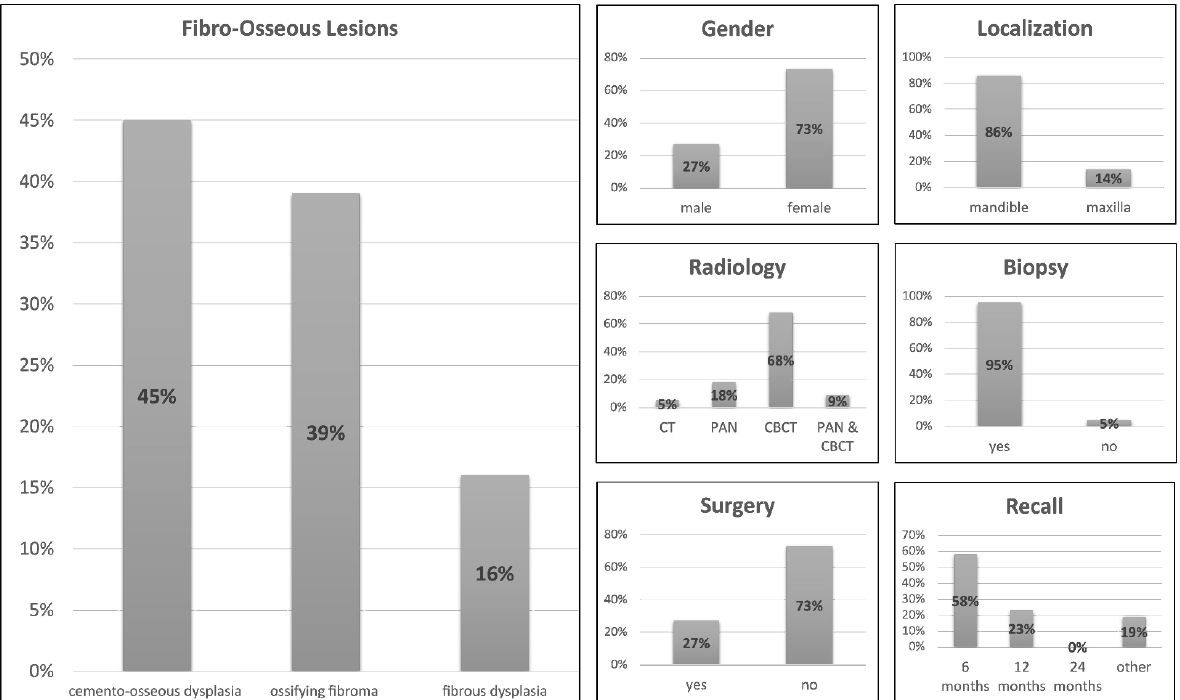
Figure 1. Overview: Parameters for all fibro-osseous lesions. Table 1. Overview: Demographic, clinical, radiological, and pathological parameters for all fibro- osseous lesions.